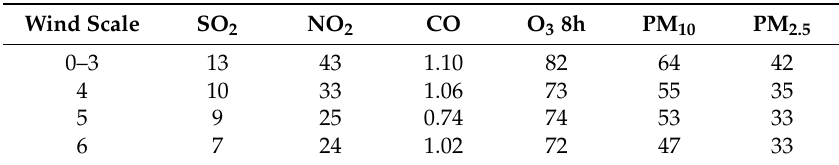
Table 4. Air pollutant concentrations based on wind-scale classification in Shenzhen from March 2013 to February 2014 (mg/m 3 for CO, µ g/m 3 for others).